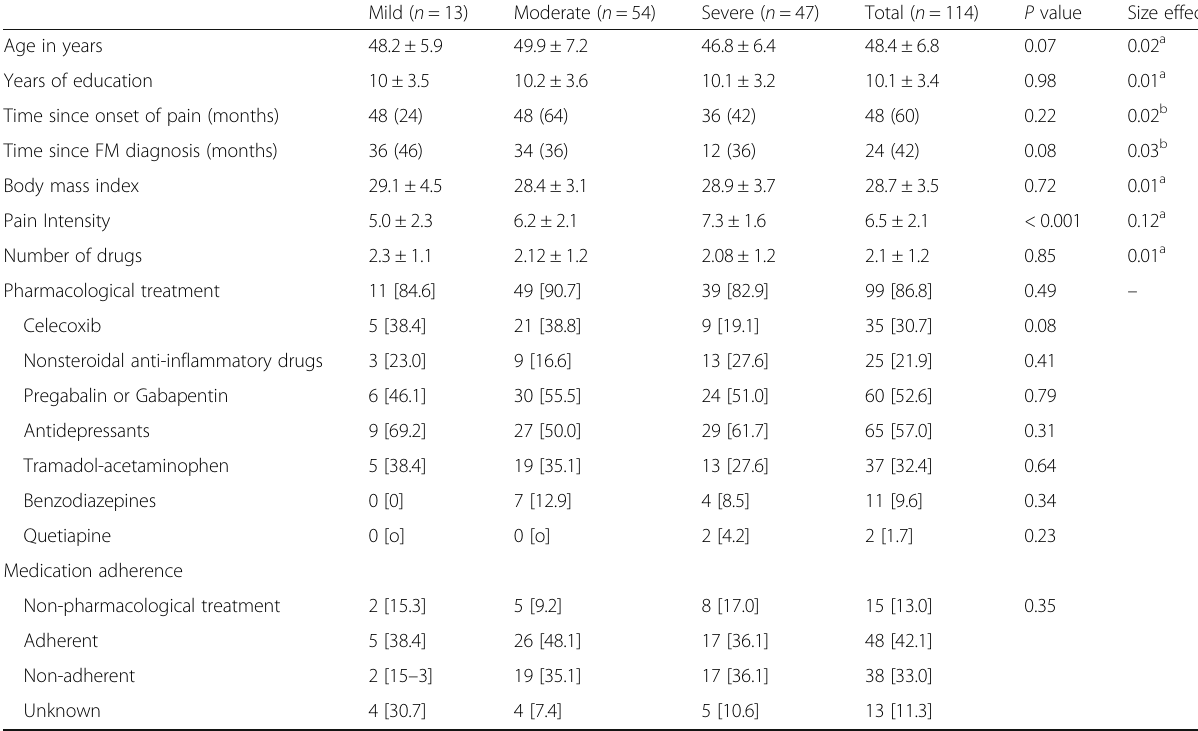
Table 1 Socio-demographic and clinical variables of the 114 patients with disability Mild ( n =